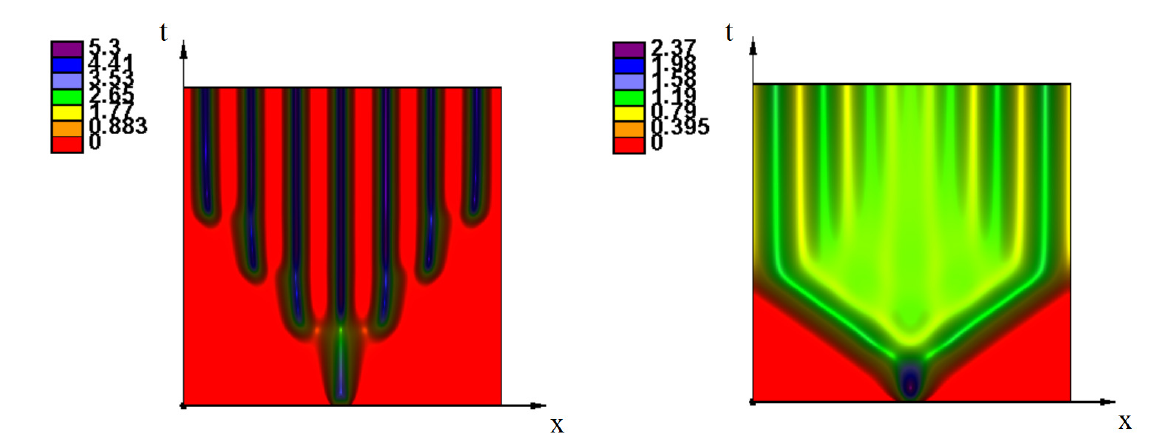
Figure A3. Level lines of the solution u ( x , t ) of Equation (1) on the ( x , t ) -plane. Values of parameters: r = 1, q = 1, N = 0.1, τ = 0, f ( u ) = 0 (left and middle), the maximum of the initial condition 0.9, D = 0.00001, t = 130 ( left ) and D = 0.0001, t = 75 ( right ). Propagation of waves in the case of time delay in the immune response term.